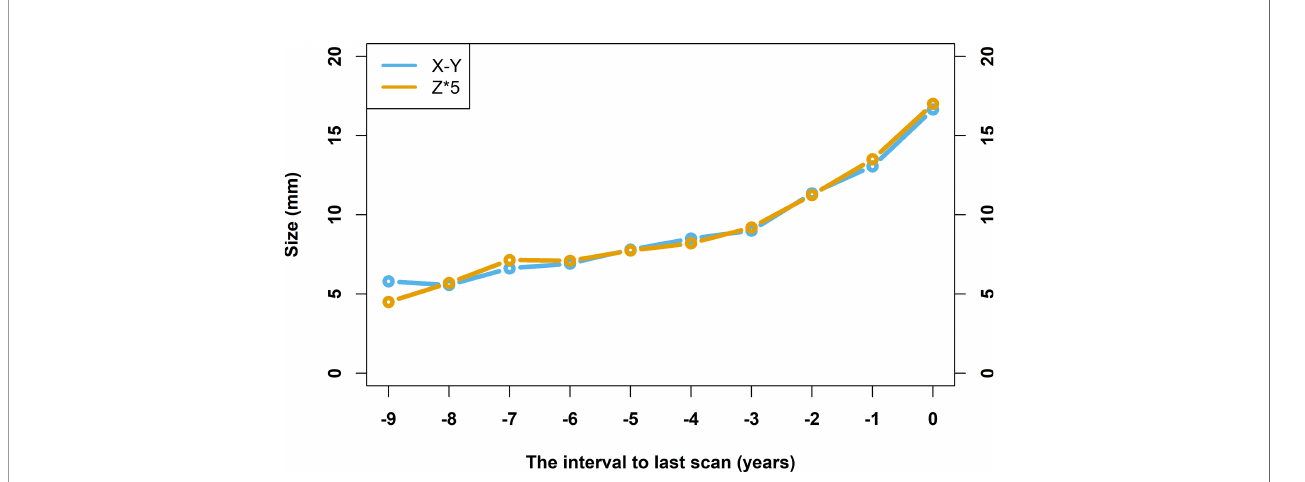
FIGURE 3 | Line chart of nodule size changes over time. The horizontal axis takes the time of con fi rmed diagnosis as zero, and the rest of the time is de fi ned relative to the time of con fi rmed diagnosis. The vertical axis indicates the size of the lesions, unit in mm. The line in yellow represents the average diameter of the largest slices, and the line in blue represents the product of the number of involved slices that lesions appeared in and the thickness of the slice (5 mm).